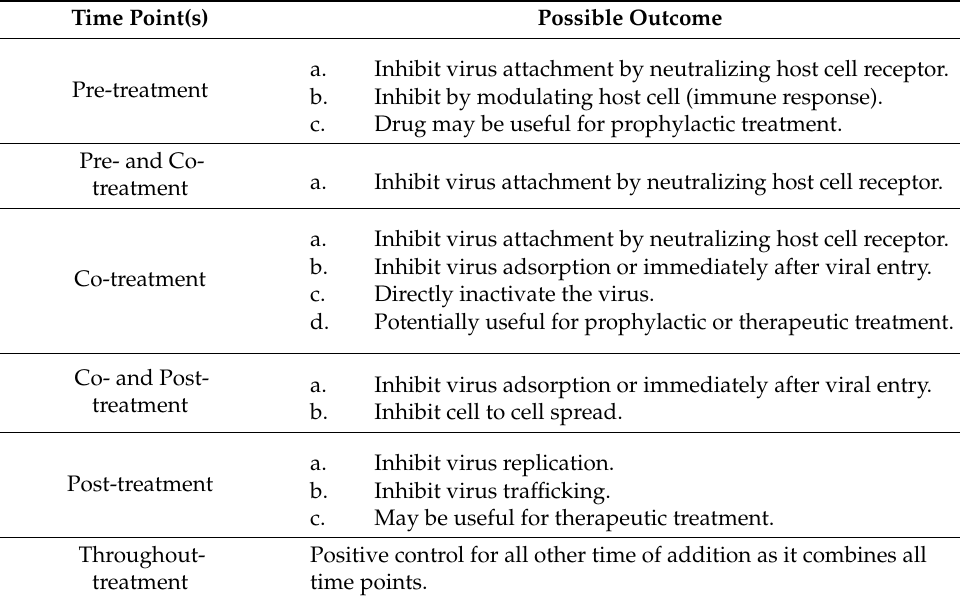
Table 1. Basic interpretations from time of addition